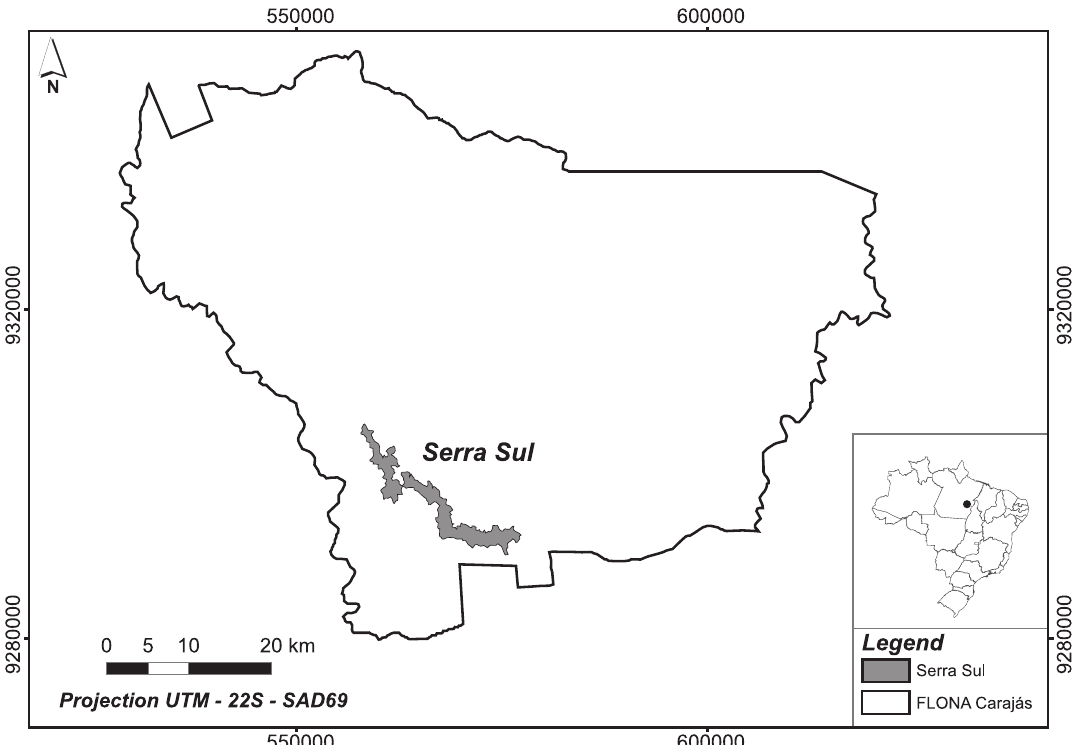
Figure 1. The study area, Serra Sul at Carajás National Forest, state of Pará is identified by dot on the inset map of